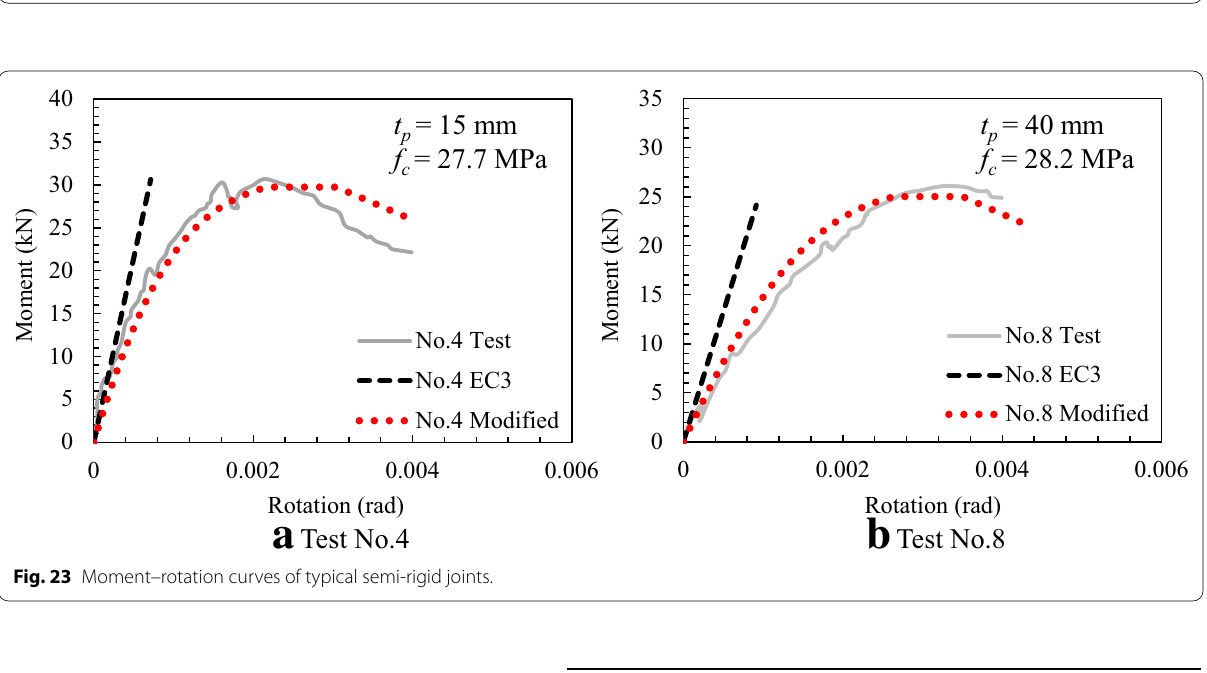
Fig. 22 Load transferring mechanism of semi‑rigid joint and deformation decomposition.